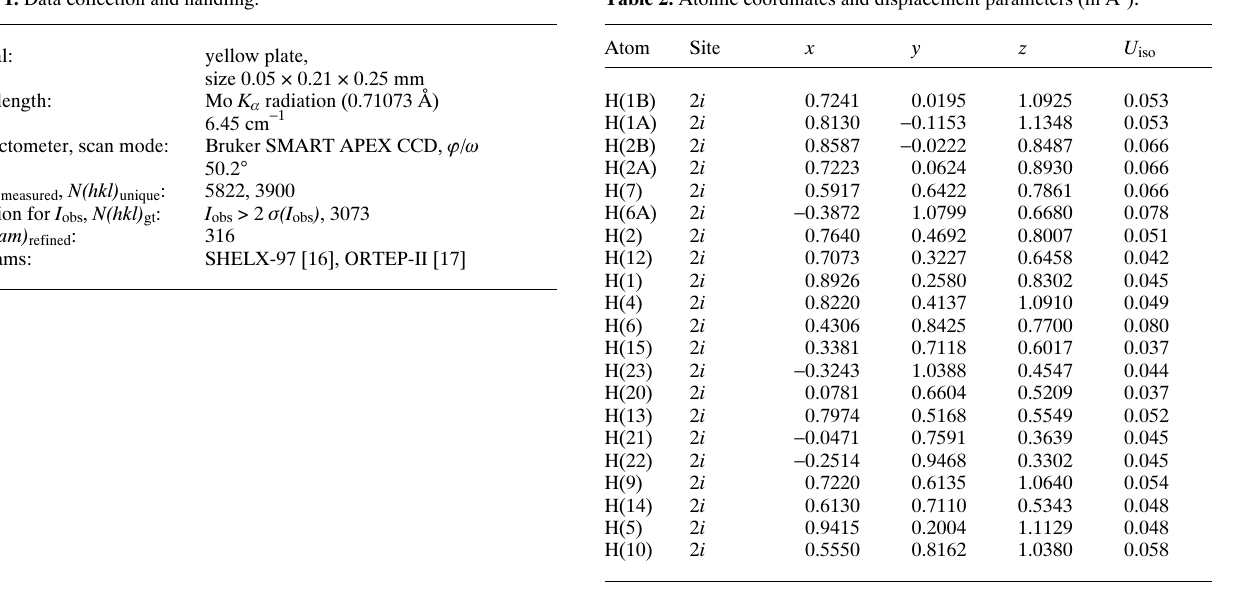
Table 2. Atomic coordinates and displacement parameters (in Å 2 ) . Table 1. Data collection and